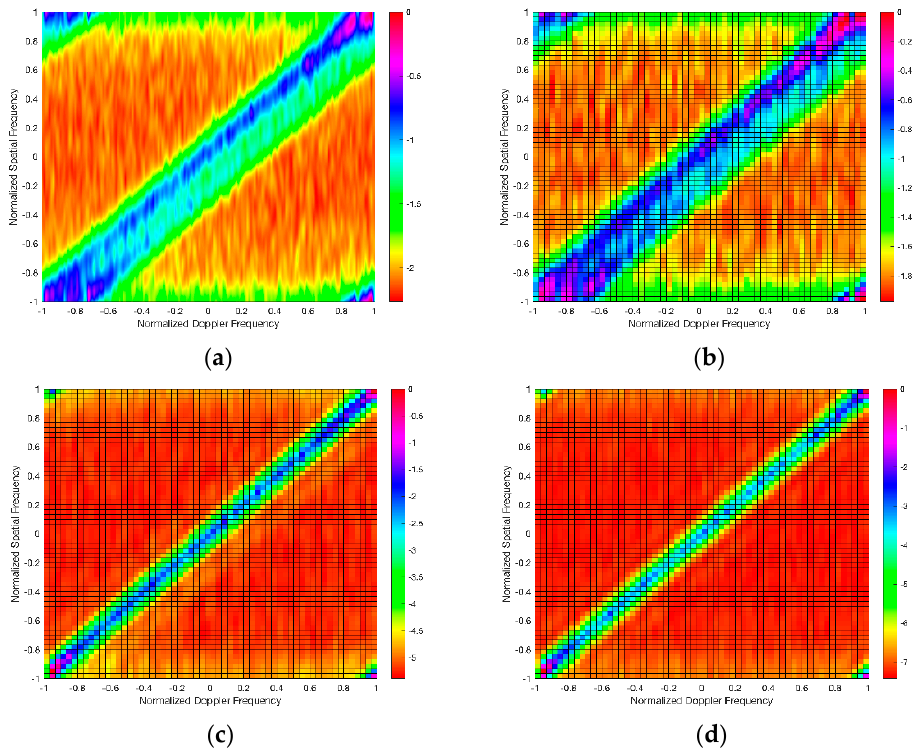
Figure 2. Spatial–temporal clutter spectra in scene 1 using the ( a ) Full–STAP, ( b ) SR–STAP, ( c ) CM– STAP, and ( d ) proposed algorithms.